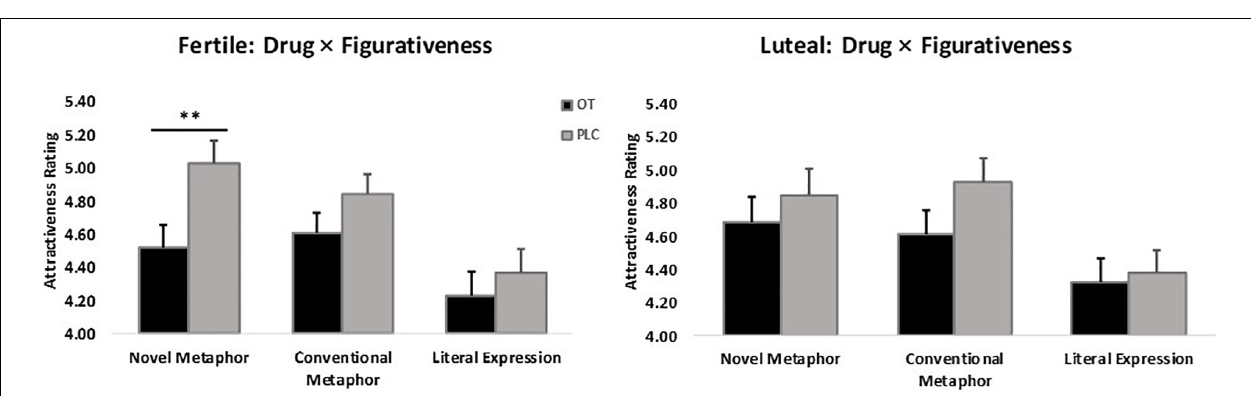
FIGURE 3 | Women’s menstrual cycle × figurativeness of men’s compliments × treatment interaction affects attractiveness ratings ( n = 62). ** p < 0.01, two-tailed t -test. Bars indicate M ± SE.